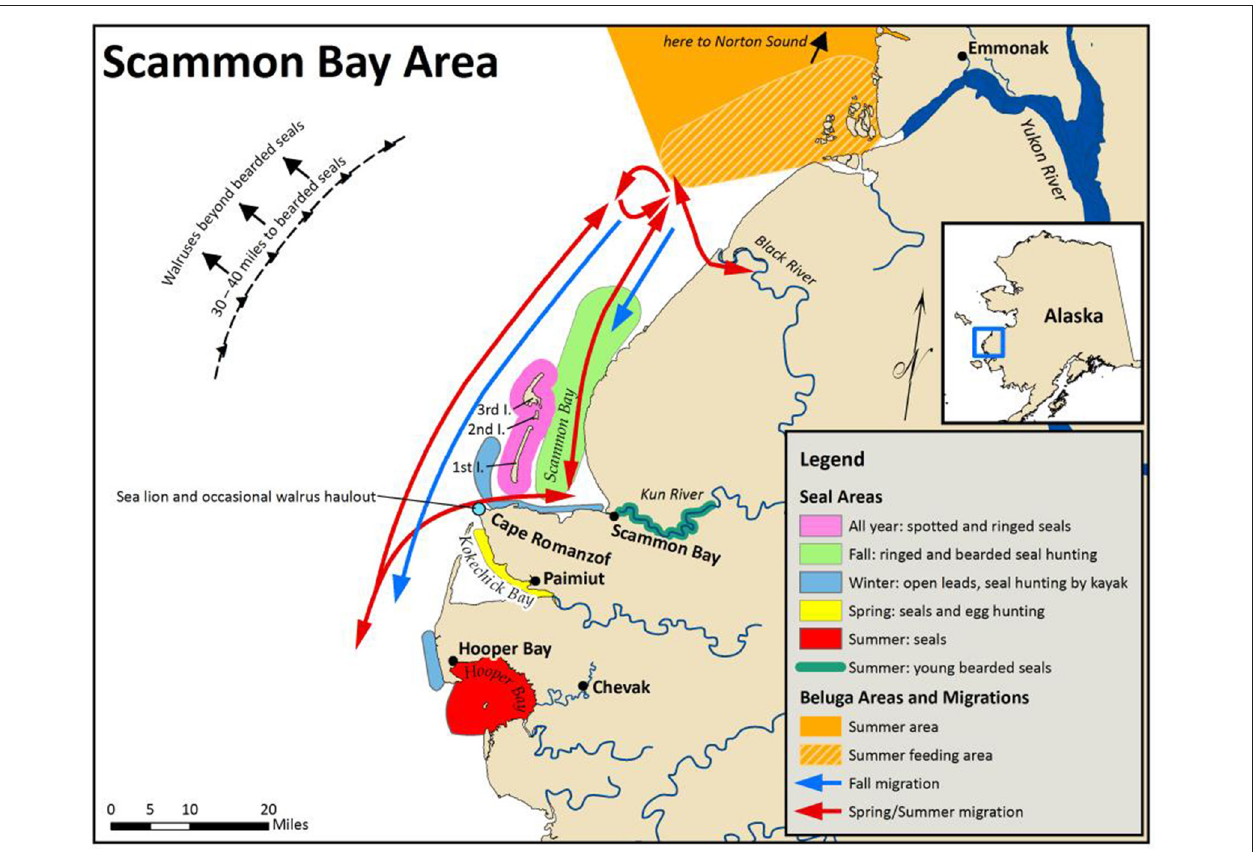
FIGURE 5 | Traditional knowledge about the movements and behavior of marine mammals near Scammon Bay, Alaska as described during interviews in January